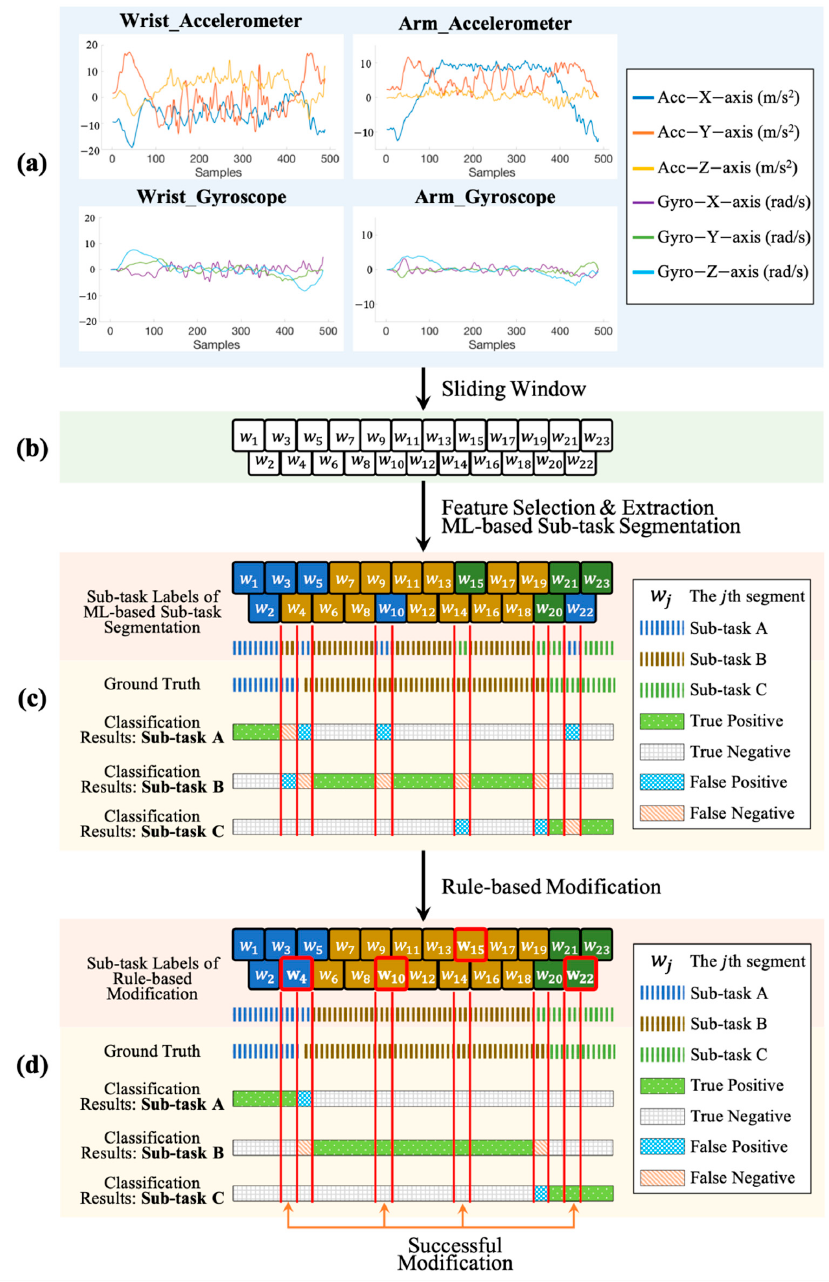
Figure 8. An example of the signal performed by the health subject and the processes of the proposed sub-task segmentation. ( a ) The accelerometer and gyroscope signals collected from the IMUs placed on the wrist and arm. ( b ) The divided segments obtained from the process of sliding window. In this example, there are 23 segments ( c ) The classification results for sub-task A, B and C after the processes of feature extraction and ML-based sub-task segmentation, where the TP, TN, FP, and FN are annotated. ( d ) The classification results after the processes of rule-based modification, where the modified sliding segments are highlighted in red square (e.g., w 4 , w 10 , w 15 , w 22 ) and the successful modification results are